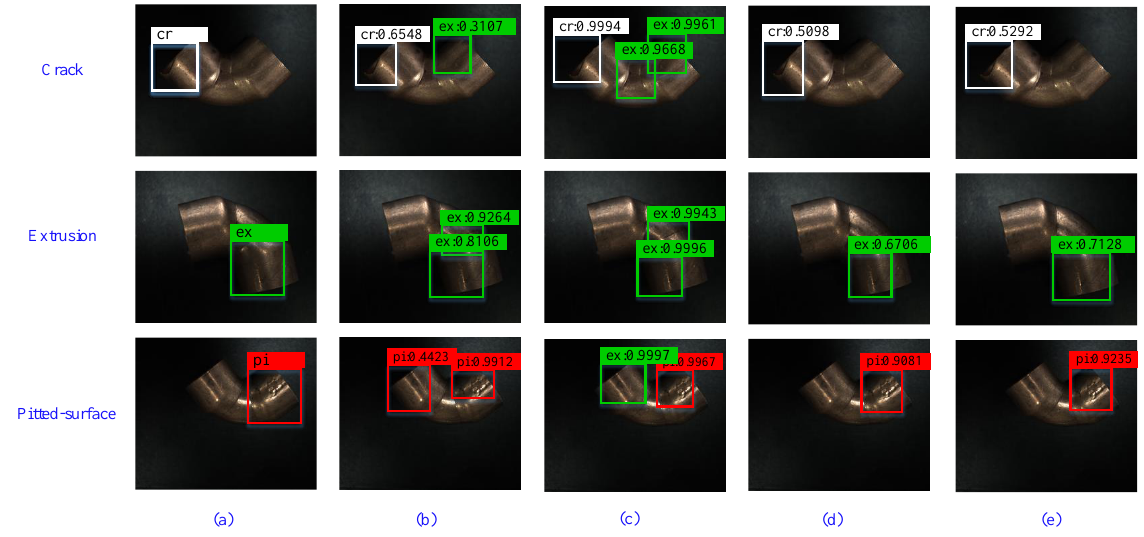
Figure 6. A brief view of the prediction results on TJ-CE-DET. There is only one defect in each image. SSD and Faster RCNN predict two or three defects though they get higher scores. YOT-Net gets higher scores than the Original YOLOv3. ( a ) Ground truth, ( b ) SSD, ( c ) Faster R-CNN, ( d ) YOLOv3, ( e ) our proposed